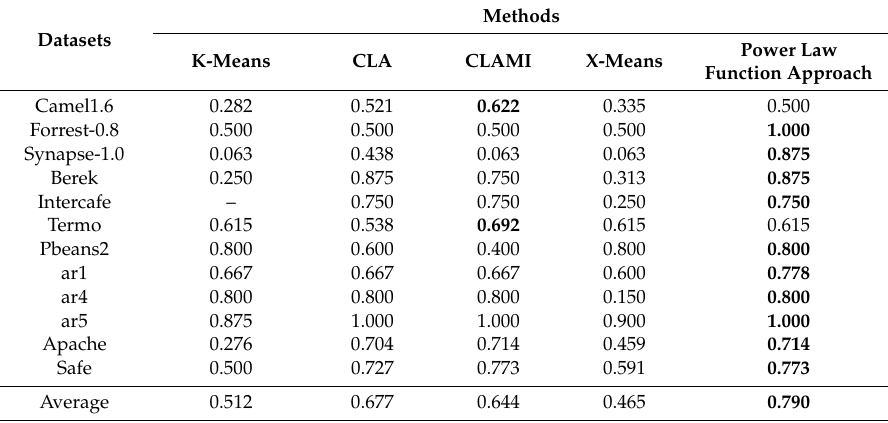
Table 5. Comparisons of recall results between the proposed approach and other